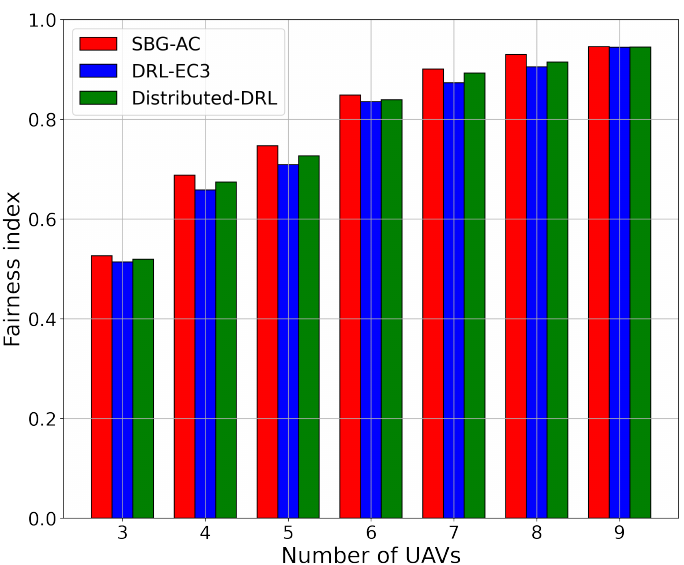
Figure 4. Fairness index for a 3-, 4-, 5-, 6-, 7-, 8-, and 9-UAV network. For the energy consumption metric, we compared the SBG-AC model with the two models in terms of the normalized average energy consumption for different numbers of UAVs. Figure 5 shows the normalized average energy consumption results for SBG-AC (red color), DRL-EC3 (blue color), and distributed-DRL (green color). From Figure 5, we noticed that SBG-AC, DRL-EC3, and distributed-DRL almost has the same energy consumption values for all network sizes. For instance, when the number of UAVs was six and nine, SBG-AC, DRL-EC3, and distributed-DRL required almost the same normalized energy consumption (20.8% and 25.7%) to reach a coverage of 71.5% and 85.2% in SBG-AC, 69.4% and 84% in DRL-EC3, and 70.4% and 83.1% in distributed-DRL. In the case of seven UAVs, DRL-EC3 required less normalized energy consumption (24%) compared to SBG-AC (25%), with coverage scores of 74.2% for DRL-EC3 and 78% for SBG-AC. For other sizes, SBG-AC beat DRL-EC3 and distributed-DRL with a small deviation in their values. We observed that the energy consumption values did not vary when the number of UAVs increased in these models. Indeed, more UAVs might lead to fewer movements compared to fewer UAVs due to the restrictions in the connectivity and interferences with other UAVs. As a result, the UAVs did not consume more energy for the